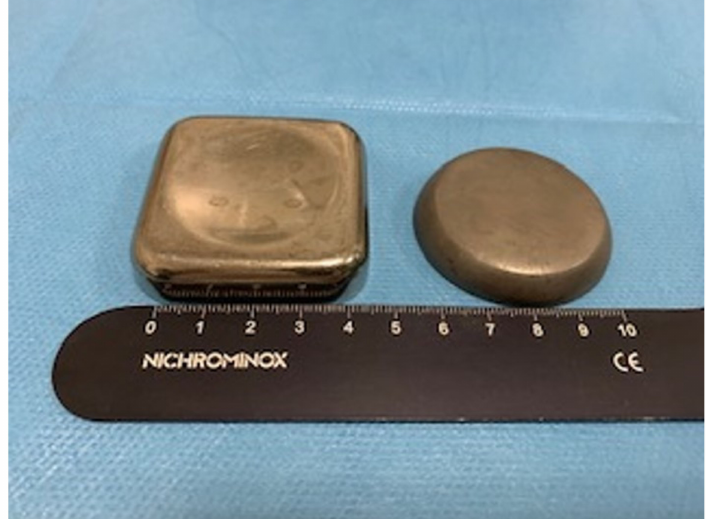
Figure 4. Detail of the mechanical counter-mold used for the APG clots.